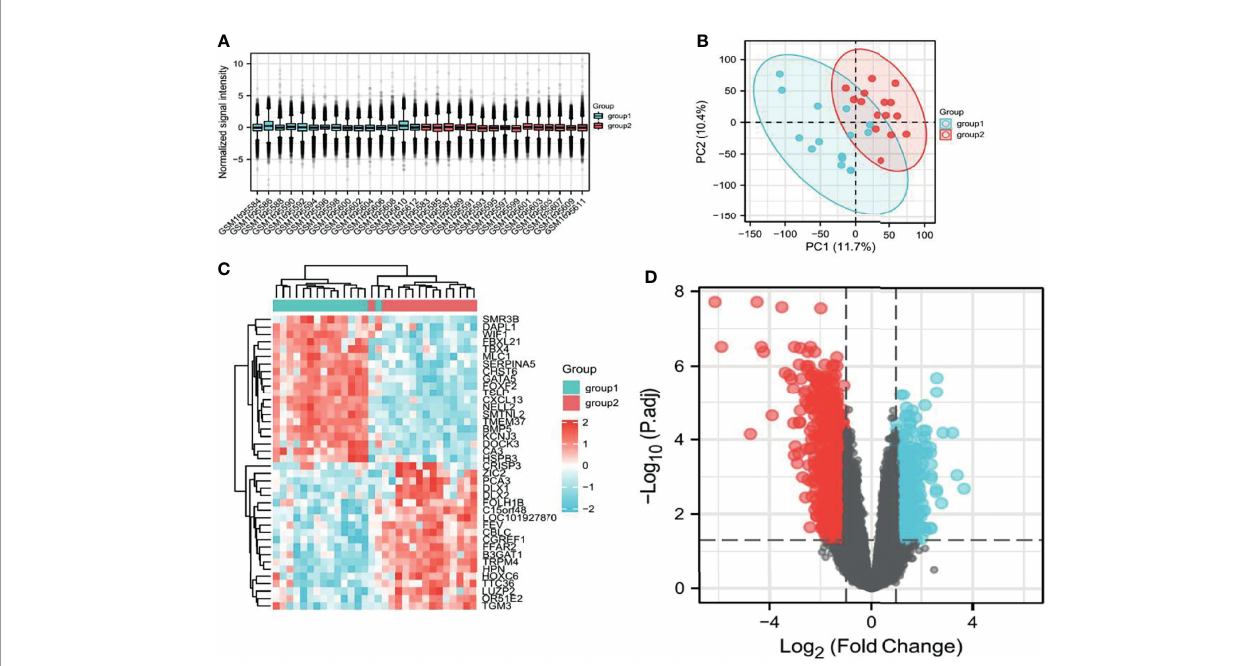
FIGURE 1 | Screening of relevant PCa genes in TCGA and GEO databases. (A) Sample homogeneous representation in the GSE69223 dataset. (B) , PCA indicates that the selected samples have good heterogeneity. (C) Differentially expressed genes between tumors and non-tumors. (D) Distribution of differentially expressed